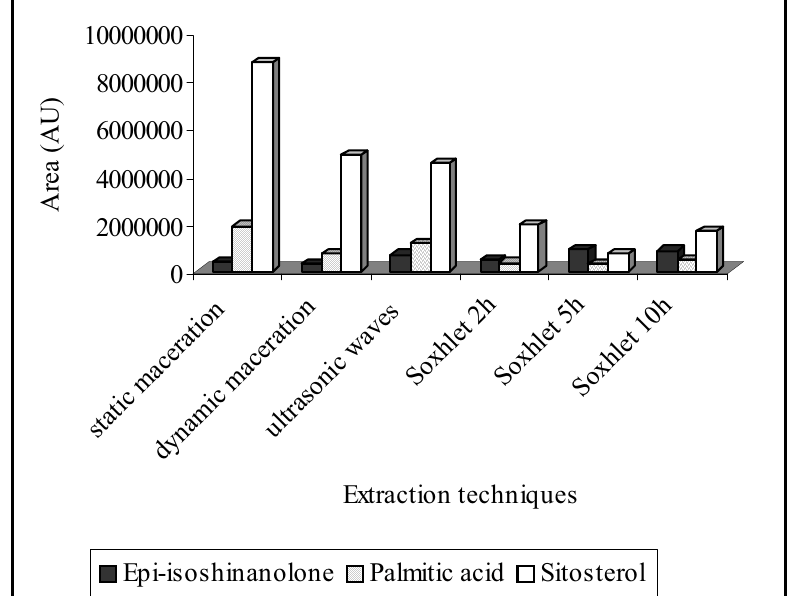
Fig. 5 – Profile variation of the main constituents of the Plumbago scandens root extracts obtained by different extraction